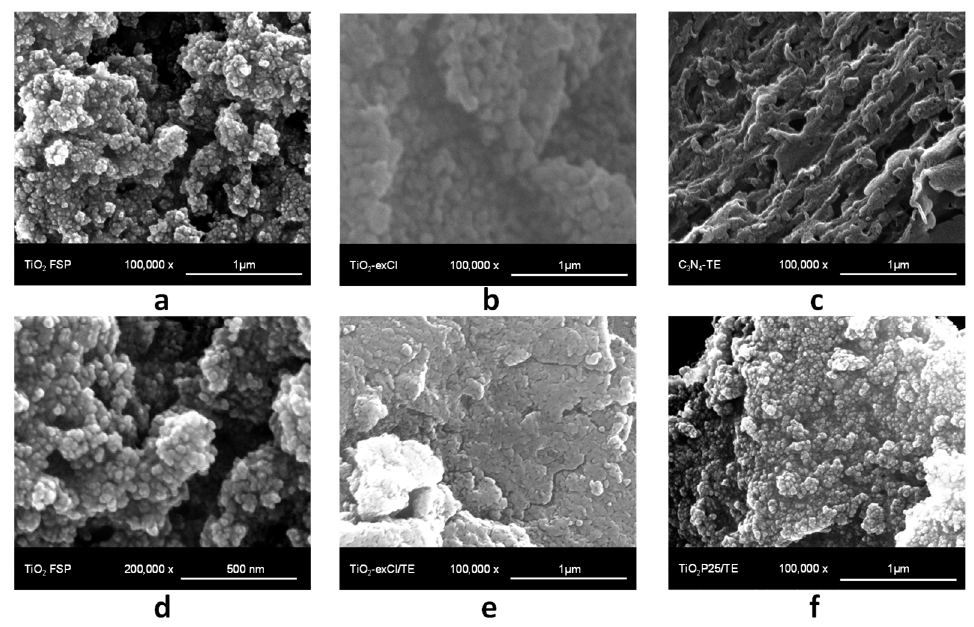
Figure 2. SEM pictures of ( a , d ) TiO 2 -FSP at different magnifications: ( b ) TiO 2 exCl, ( c ) C 3 N 4 -TE, and both composite materials, ( e ) TiO 2 exCl/TE and ( f ) P25/TE. The FTIR spectrum of the C 3 N 4 -TE sample (see Figure 3) confirmed the carbon nitride structure, showing the major bands of this structure attributable to the C-N-C and C-NH- C units, i.e., 1632, 1560, 1410, 1325, and 1250 cm − 1 , typical for the stretching vibration modes of the heptazine heterocyclic ring (C 6 N 7 ) units, as long as the absorption at 887 and 804 cm − 1 correspond to the N-H deformation mode and a bending mode of the triazine units, respectively [31].